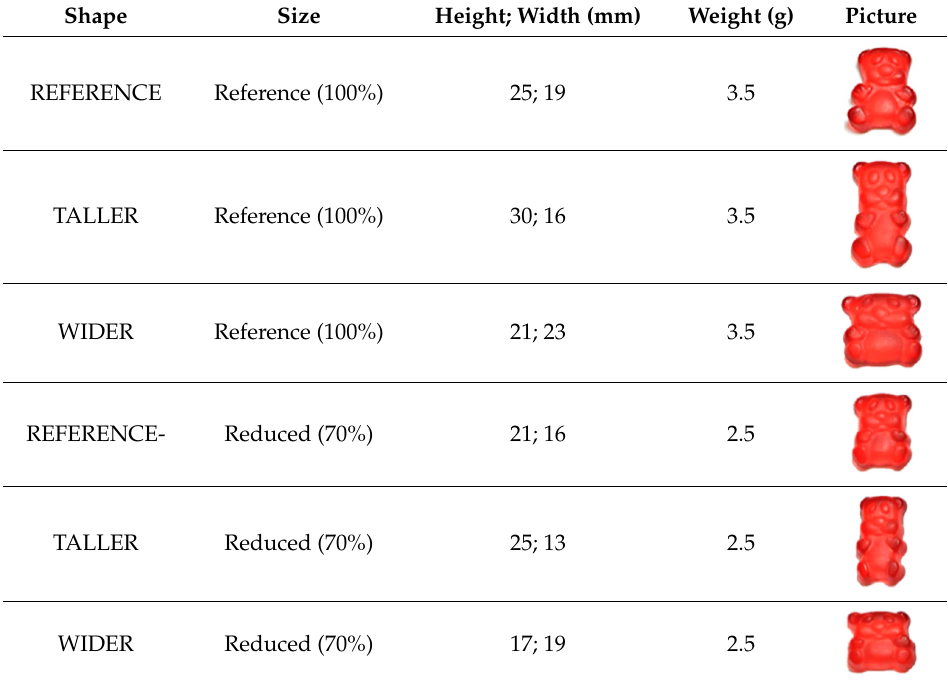
Table 2. Reference and variant gummy candy dimensions, weight and pictures. Shape Size